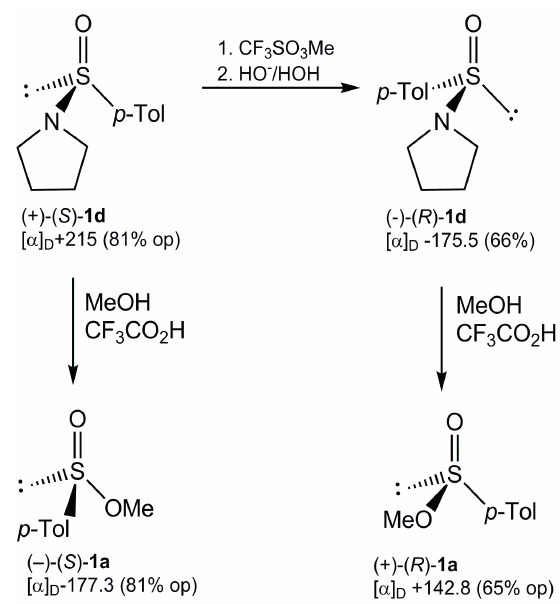
Scheme 9. Synthesis of enantiomeric O-methyl p -toluenesulfinates ( 1a ) from N - p -tolylsulfinylpyrrolidines ( 1d ).